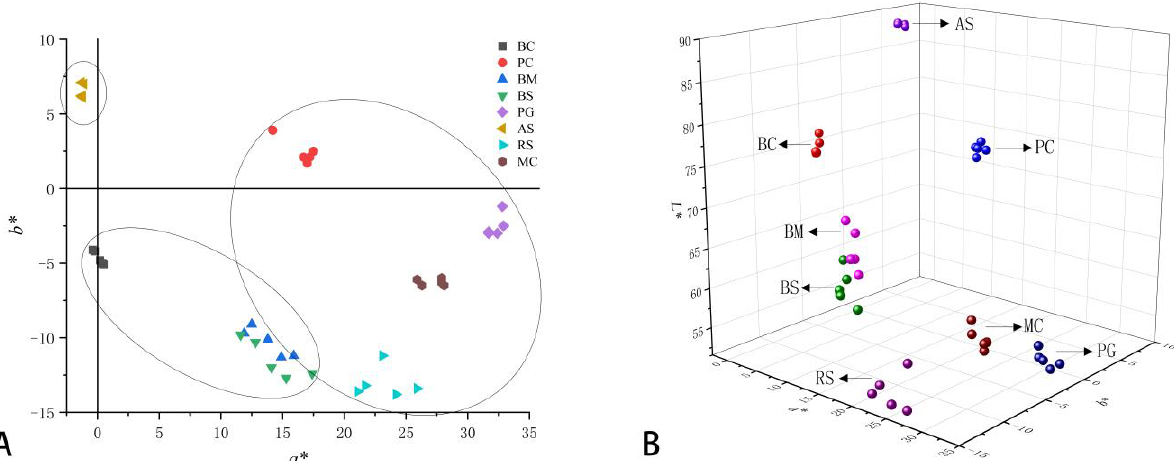
and c * (R 2 = 0.799, p < 0.01); we found that a * and c * both increased with the decrease of L *. (Figure 3). In addition, the correlations among L *, a *, b *, and c * were different among different color groups of H. syriacus . In the red-purple group, there was a strong negative correlation between L * and c * (R 2 = 0.812, p < 0.01), and in the purple group, there was a strong positive correlation between L * and a * (R 2 = 0.803, p < 0.01) and L * and b * (R 2 = 0.976, Note: In the same column, different letters indicate significant differences at p ≤ 0.05. p < 0.01) (Figure 4).